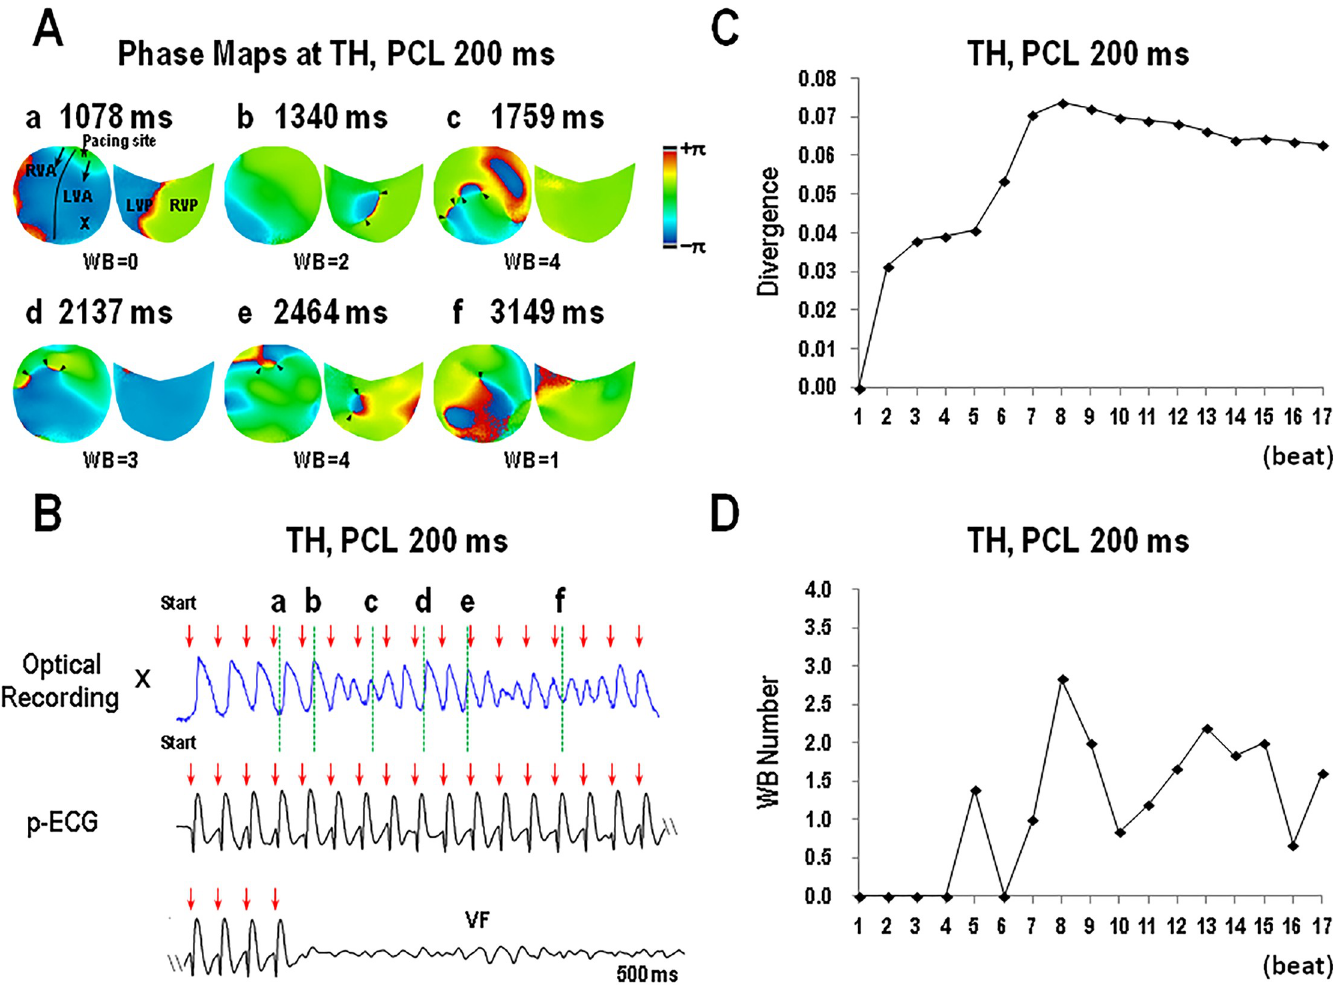
Fig 7. Simultaneous recordings of epicardial activations (A), pseudo-ECG (B), dynamic changes of divergence (C), and epicardial wavebreaks (D) at the start of burst ventricular pacing at pacing cycle length (PCL) 200 ms during therapeutic hypothermia (TH, 30˚C) in an episode of high divergence (data is from heart #7). Note that the divergence increased to 0.031 at the 2 nd beat and remained as high as 0.63 at the 17 th beat. VF was inducible after stopping pacing (B). Black triangles in panel A indicate points of wavebreak